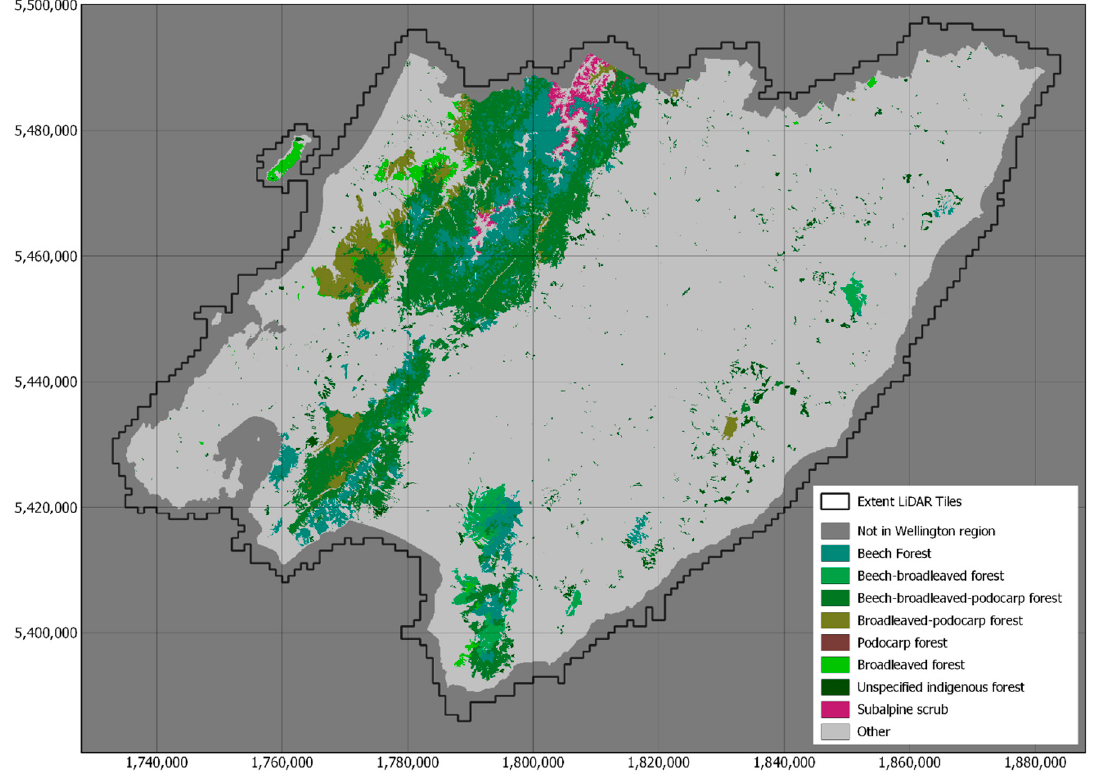
Figure 3. Spatial distribution of forest alliance groups in the Wellington Region. Most indigenous forests are in the Tararua mountains which form a north to south-west axis. Most of remaining indigenous forests are in Aorangi mountains in the southernmost part of region. Map projection is NZTM.